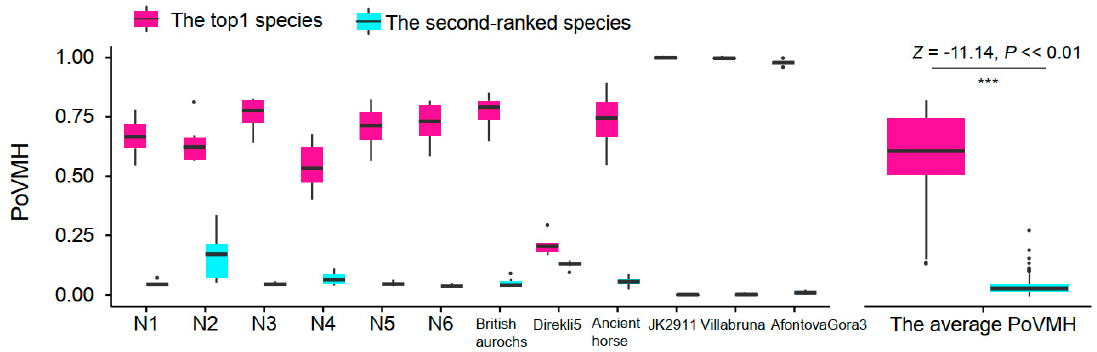
Figure 2 . The percentage of valid mapping hits (PoVMH) of the top one and the second-ranked species in the species ranking (SR) based on the BLAST search results generated using the whole mtDNA database. The range is represented by whiskers, individual data points are shown using dots, the upper quartiles and lower quartiles are denoted by the boxes, and the medians are shown using the central lines. The n in each species was seven, and the n in the average PoVMH was 84.